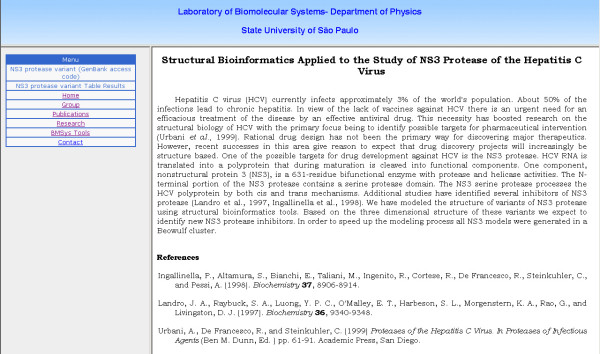
Database interface. The database user interface provides user friendly menus. In the menu of main page there are links to NS3 protein variant access codes of the Genbank, which lead to another page with the structural information and analysis about the generated model, such as a small ribbon representation, the atomic coordinates (model and template), and sequence in fasta format (model). The accuracy of the model can be viewed at link "NS3 protease variant table results" which shows results of values of the 3D Profile, rmsd, G-factor, and Ramachandran plot for each model.